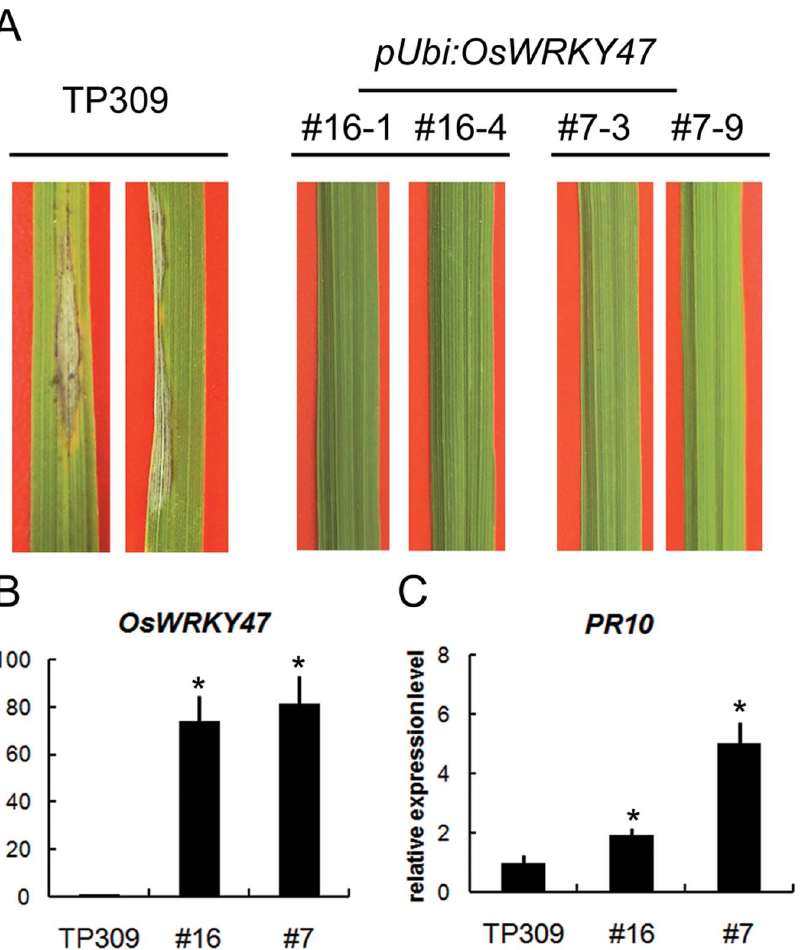
Figure 8. Overexpression of OsWRKY47 enhanced rice resistance to Magnaportheoryzae strain 96-4-1a. A: The disease symptoms on TP309, pUbi:OsWRKY47 # 16 and # 7 transgenic plants at 7 days post-inoculation. The inoculation experiments were repeated three time (n=15 seedlings) with similar results. B, C: The expression levels of OsWRKY47 and PR10 in TP309 and pUbi:OsWRKY47 transgenic plants determined by quantitative RT-PCR. The expression levels were standardized to OsUBQ and the value in TP309 was set at 1.0. Error bars in (B) and (C) represent the SD from three biological replicates, each containing at least 10 seedlings. The expression levels that differ significantly ( P , 0.05) from those in TP309 were marked with